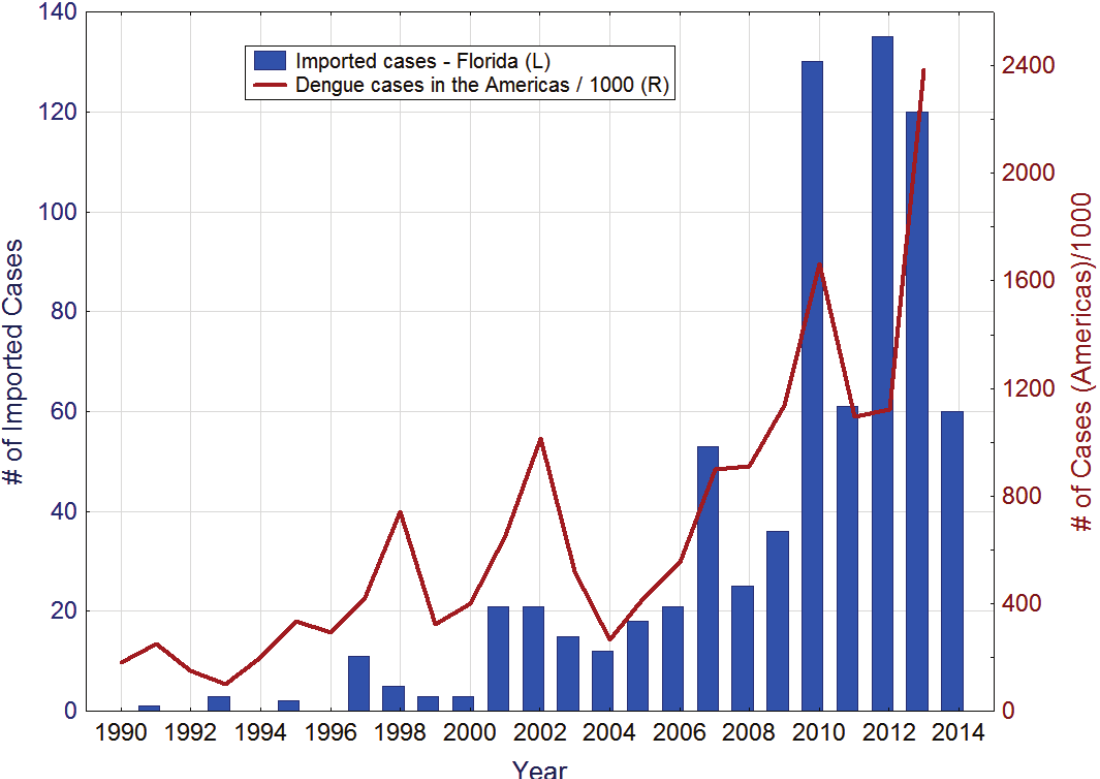
Figure 1. Imported dengue cases in Florida (left), and reported dengue cases in the Americas (right). Source: Pan American Health Organization